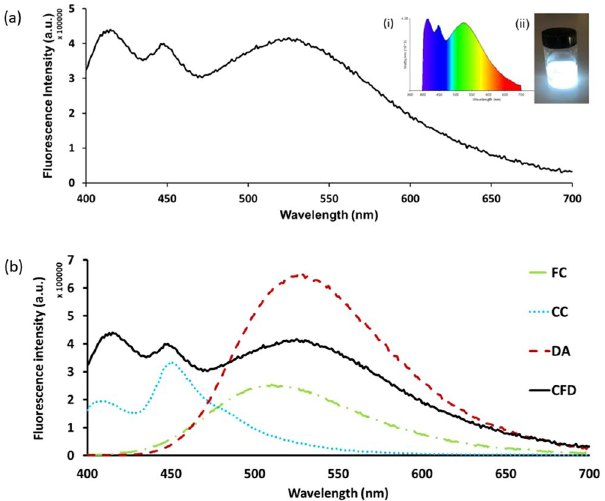
Figure 5. ( a ) Fluorescence spectrum for a mixture, CFD, of CC:FC:DA (1.375:1:7) in ethanol at 390 nm. Inset: (i) Colour spectrum and (ii) photograph of the CFD solution in ethanol under UV light (390 nm). ( b ) Shows overlay of both fluorescence spectrum from a mixture (CFD, where CC:FC:DA = 1.375:1:7) and the fluorescence spectra of the three components individually (FC, CC, DA) in ethanol at 390